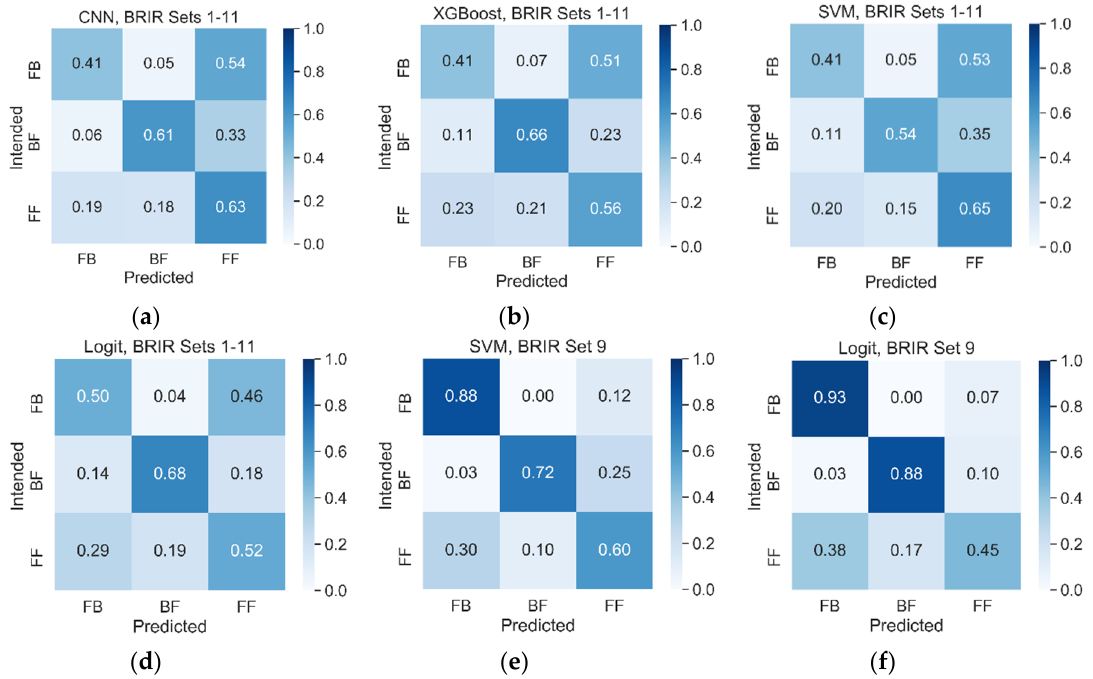
Figure 9. Examples of confusion matrices obtained under BRIR mismatched conditions: ( a ) CNN, BRIR sets 1 ‐ 11; ( b ) XGBoost, BRIR sets 1 ‐ 11; ( c ) SVM, BRIR sets 1 ‐ 11; ( d ) Logit, BRIR sets 1 ‐ 11; ( e ) SVM BRIR set 9; ( f ) Logit, BRIR set 9. Vertical axis represents the classification results obtained from the classification algorithms.